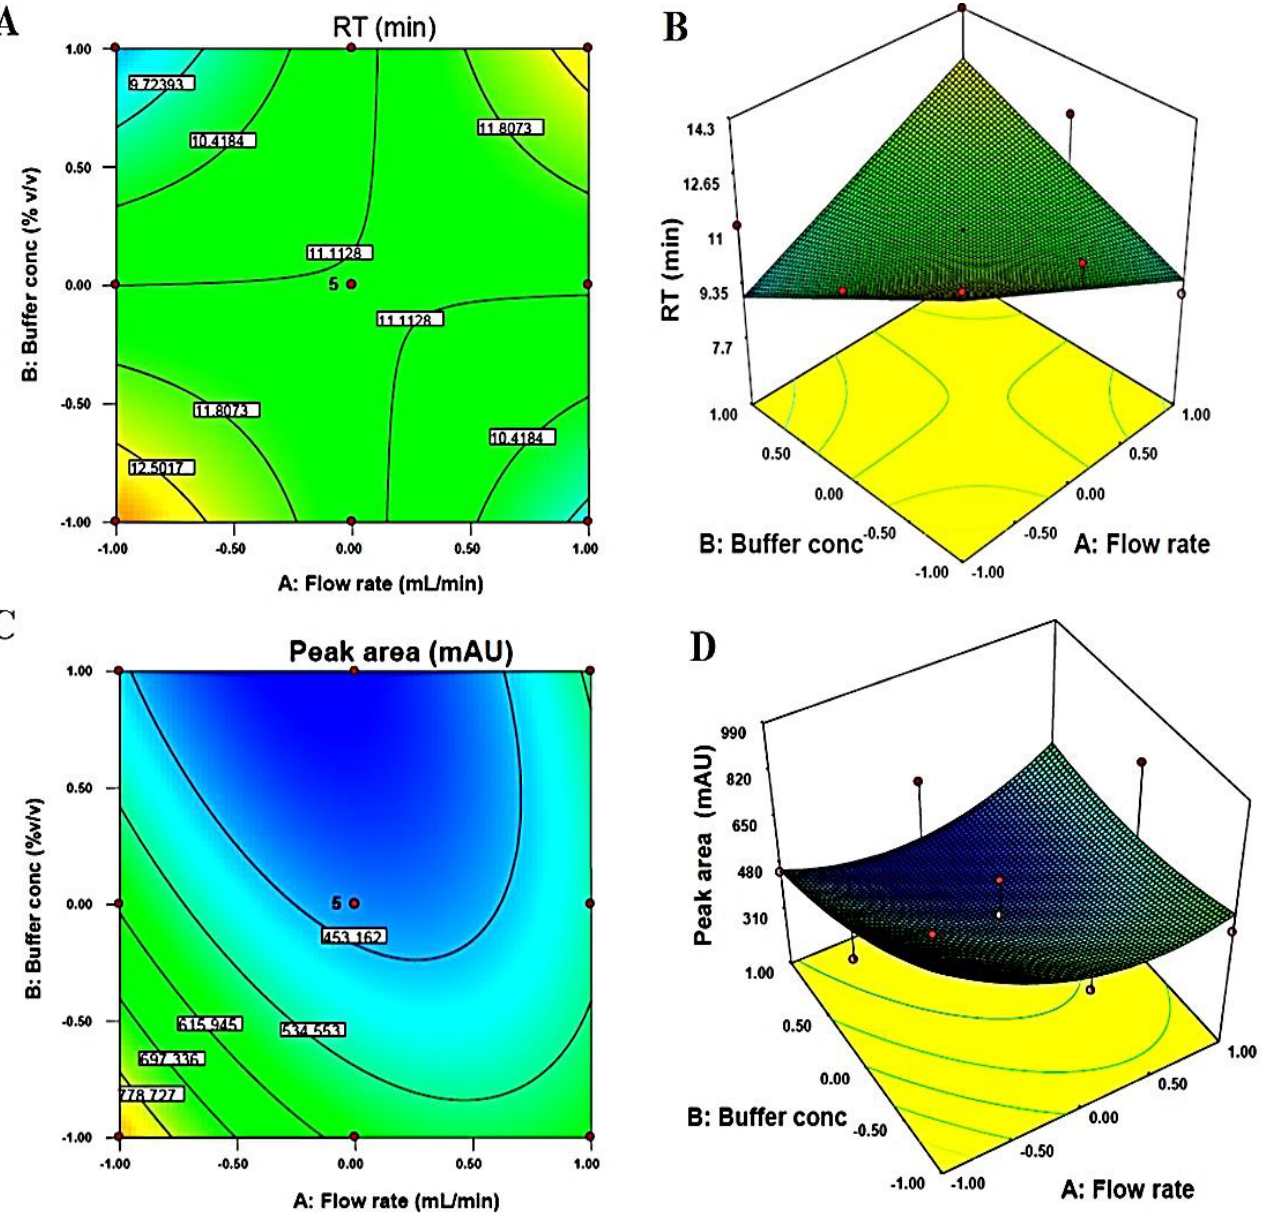
Figure 3. 2D and 3D response surface plots portraying the effect of critical attributes CMPs on various responses, ( A , B ) retention time and ( C , D ) peak area.